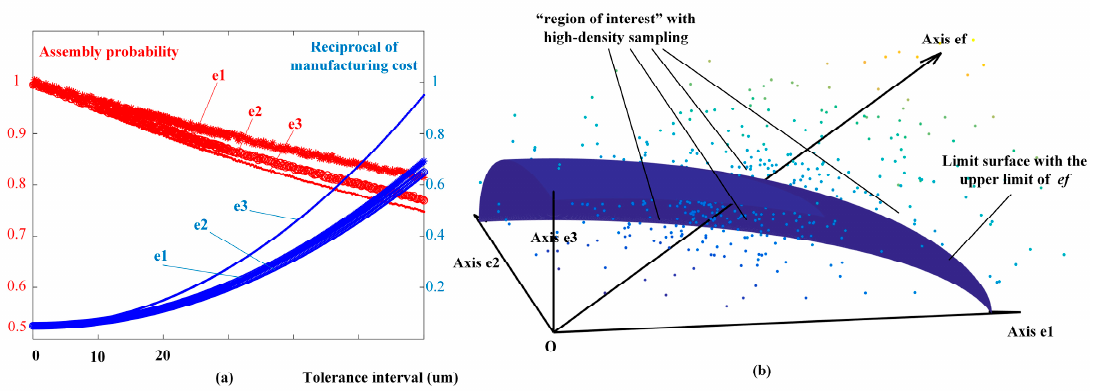
Figure 8. Distribution of assembly probability and manufacturing cost ( a ), and solution searching in a four-dimensional solution space constructed by even axes of e 1 , e 2 , and e 3 , and the uneven axis of e f ( b ).